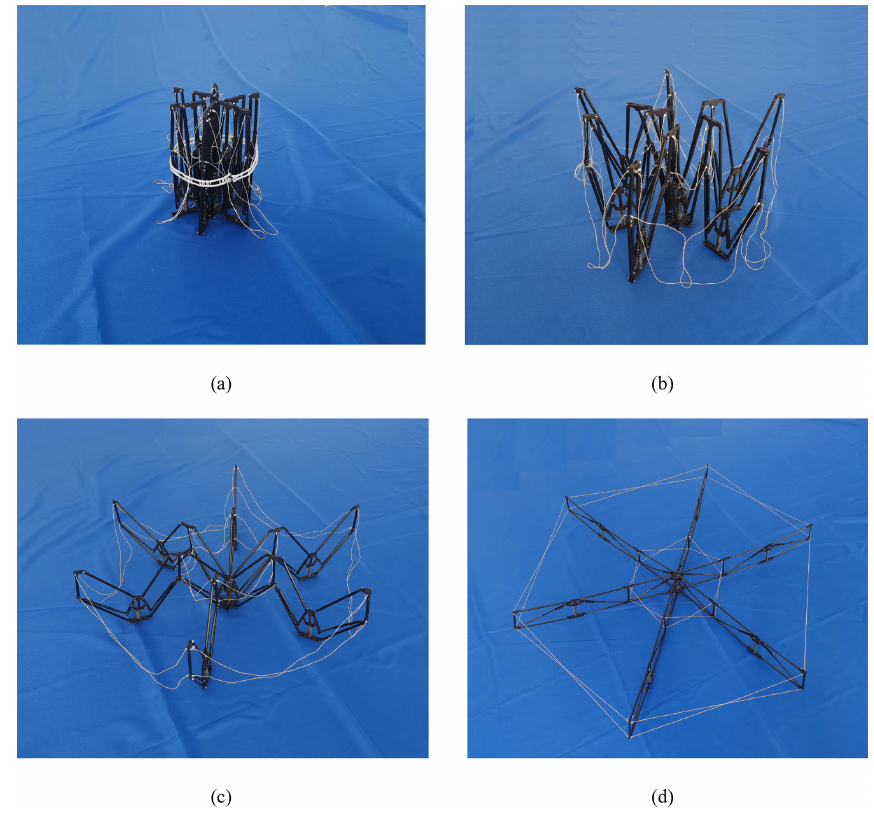
Figure 19. Hexagonal single-module principle prototype. (a) Fully folded state. (b) Semi-deployed state 1. (c) Semi-deployed state 2. (d) Fully deployed